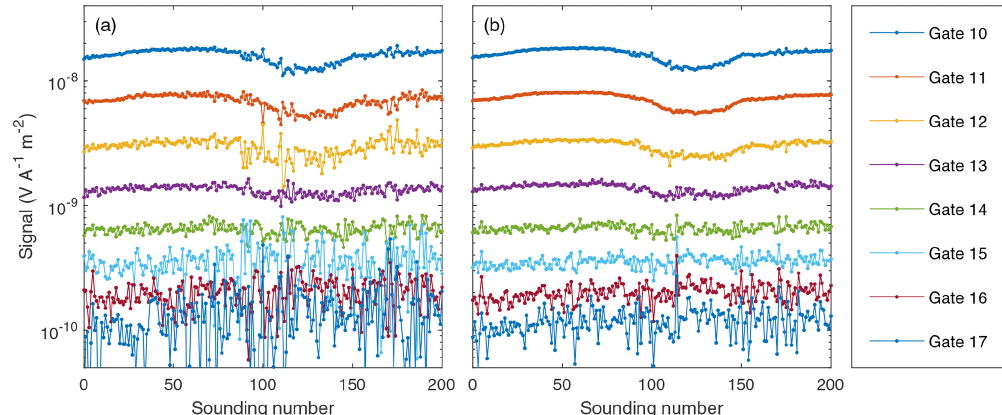
Figure 5. Gate values as a function of sounding index acquired with the tTEM system moving (a) boxcar gates and (b) semi-tapered gates; see Table 1 for gate details. The 200 soundings correspond to approximately 200m of driving. The noise using semi-tapered gates is visibly lower than for boxcar gates.